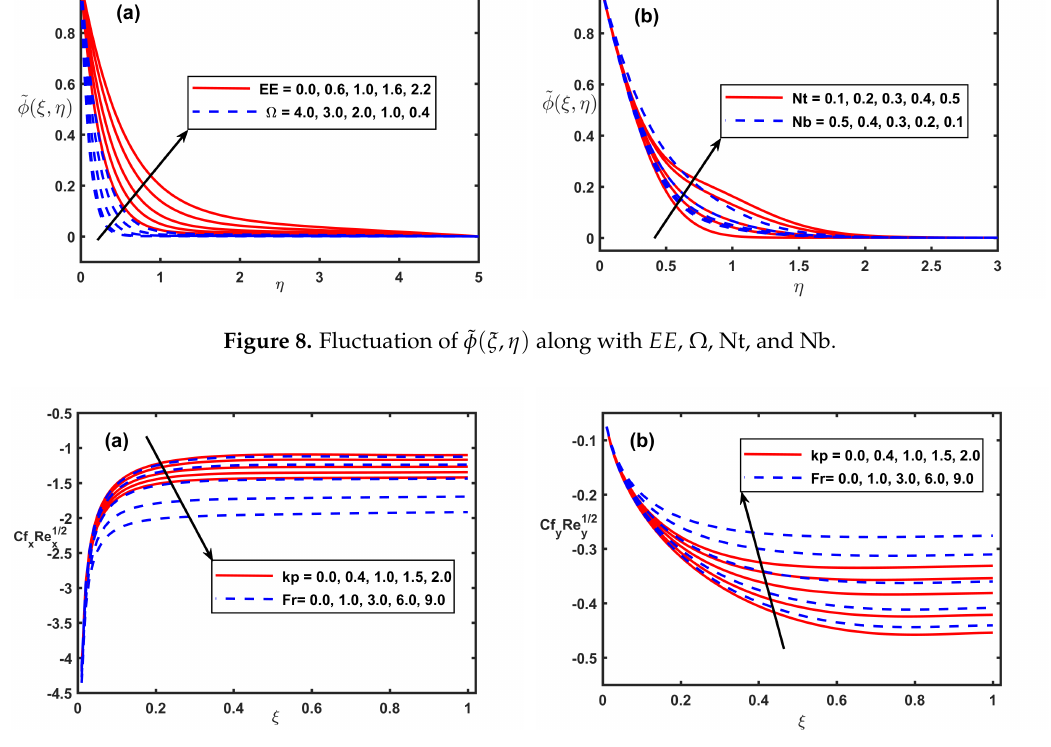
Figure 9. Fluctuation of Cf x Re 1/2 x and Cf y Re 1/2 y along with Kp and Fr.